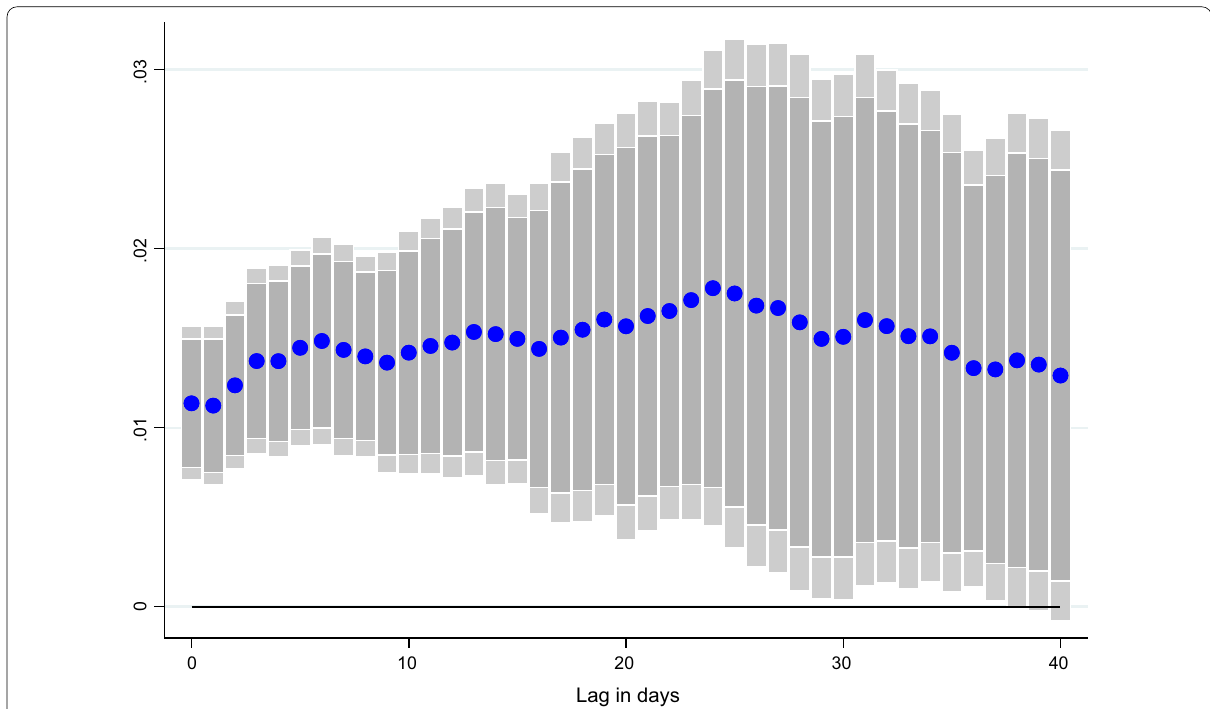
Fig. 3 Effect of vaccinations on NO 2 emissions per capita, at different lags. Coefficient β is reported for each lag ℓ (1–40), and based on �